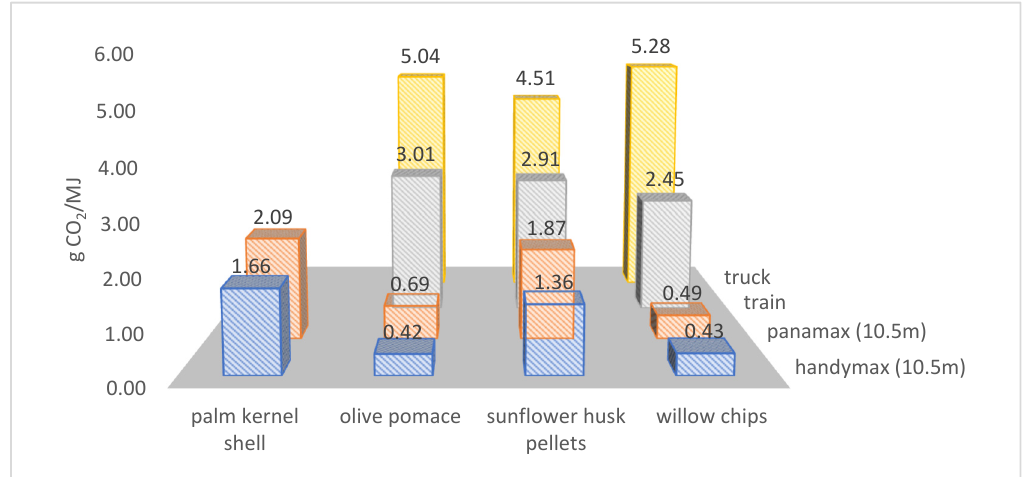
Figure 5. CO 2 emissions per calorific value of biomass in the analyzed transport chains.